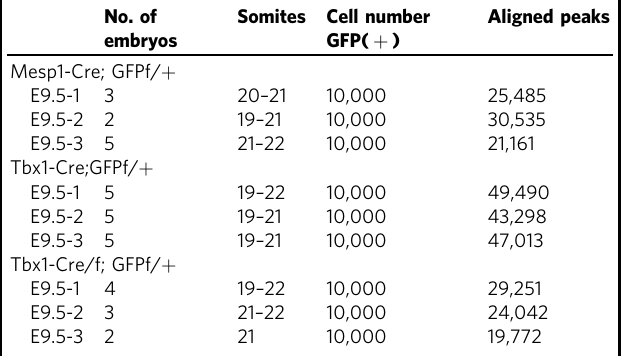
Table 2 Summary of ATAC-seq